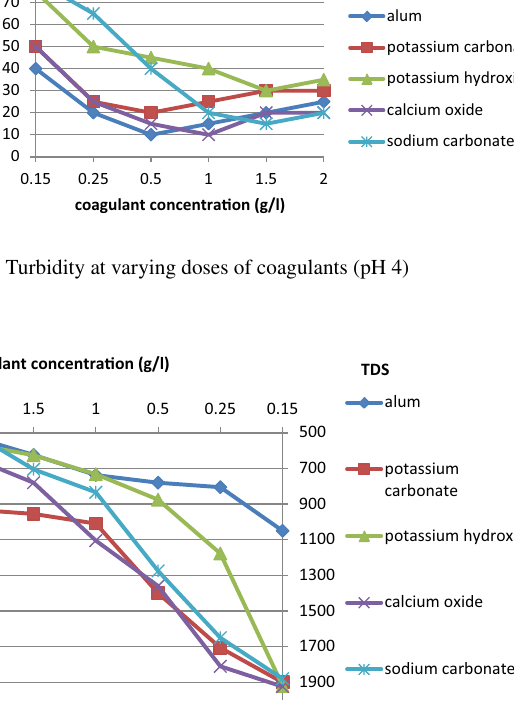
Fig. 6 TDS at varying doses of coagulants (pH